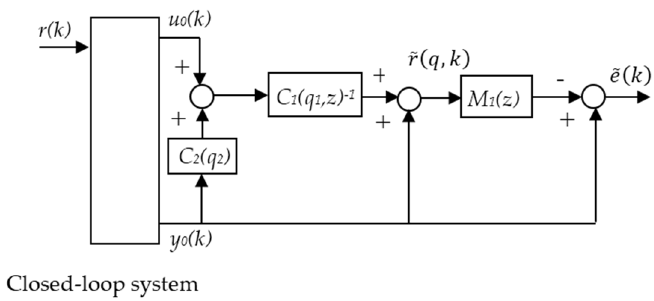
Figure 2. 2DOF PI ‐ P fictitious reference iterative tuning (FRIT) principle. Figure 2. 2DOF PI-P fictitious reference iterative tuning (FRIT)